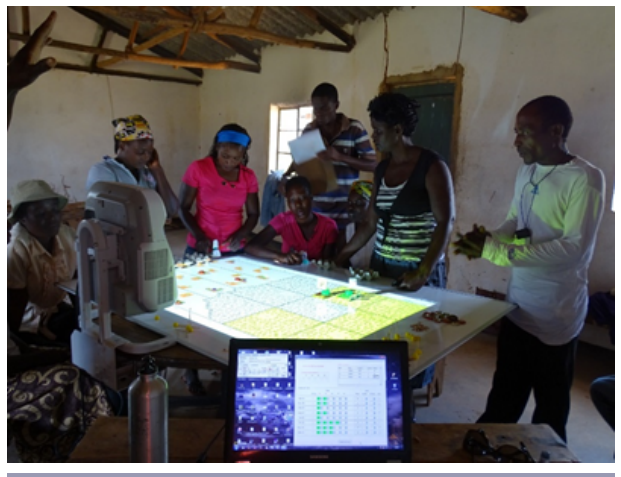
Fig. 4. The final version of the game. The projector displays the board game on a central table. Players are around the board and signify their actions by moving their pawns. Actions are entered in the computer by the operator sitting at another table (computer screen up front). The “game master”(dressed in a white long-sleeved shirt, to the right) leads the game, the “ank master” (absent in the picture) controls all the transactions, and a third facilitator records minutes (striped t-shirt, at the back).